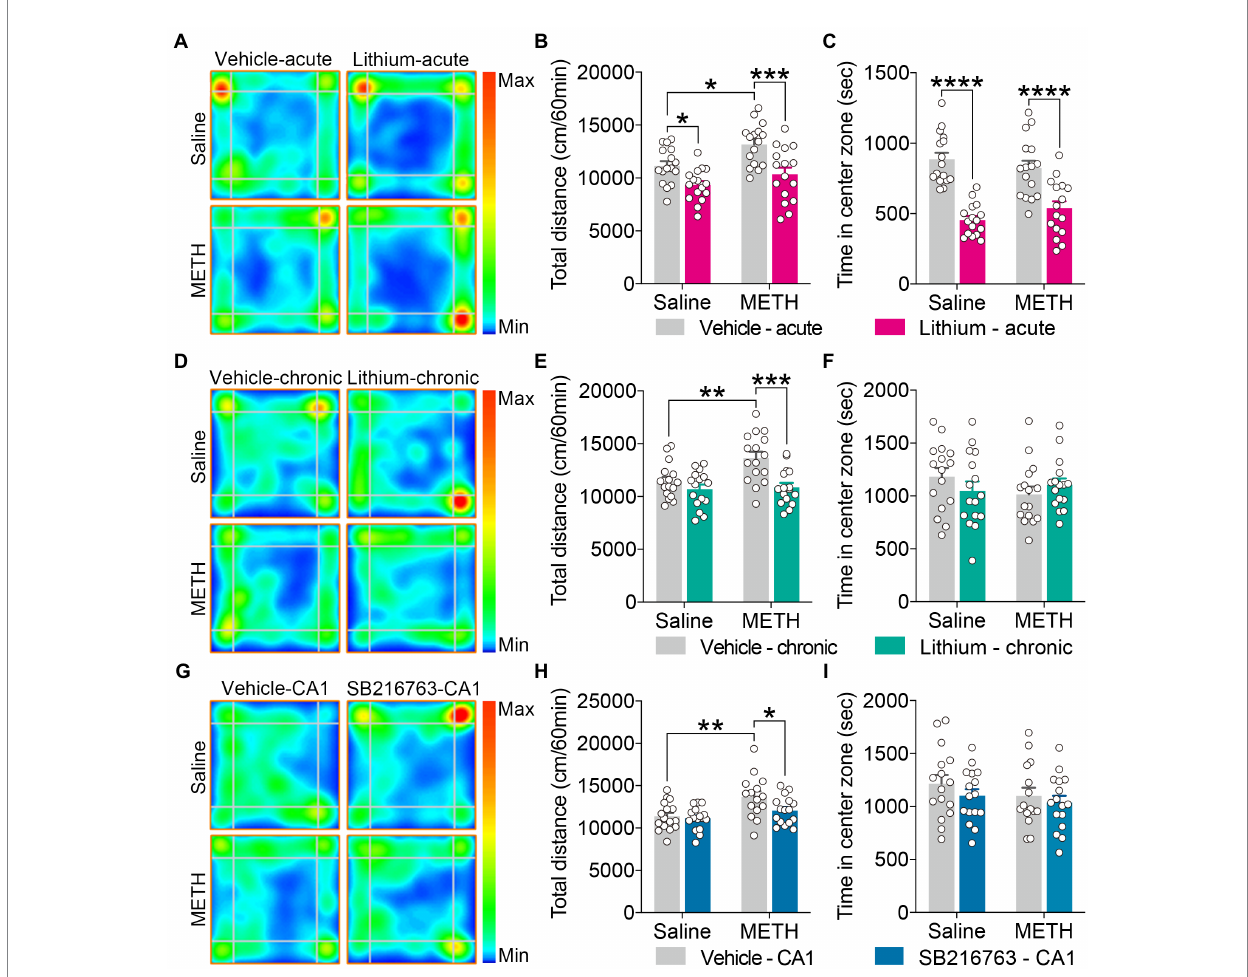
FIGURE 2 Effect of GSK3 β inhibition on adolescent METH exposure-induced hyperactivity in adulthood. Acute systemic intervention (A–C) , chronic systemic intervention (D–F) , and chronic intervention within CA1 (G–I) reduced adolescent METH exposure-induced hyperactivity in adulthood, but Li–acute administration attenuated locomotor activity and led to anxiety-like behavior. Representative heat maps show the location of the mice during the OFT (A,D,G) . Histograms show the total distance moved (B,E,H) and time spent in the center (C,F,I) during the OFT. Data are presented as the mean +/ − SEM, each symbol represents the independent of a single animal; two-way ANOVA followed by the Bonferroni post hoc test; n = 16 ~ 17/group; * p < 0.05, ** p < 0.01, *** p < 0.001, and **** p < 0.0001, comparison between the two indicated groups. See also Supplementary Figure